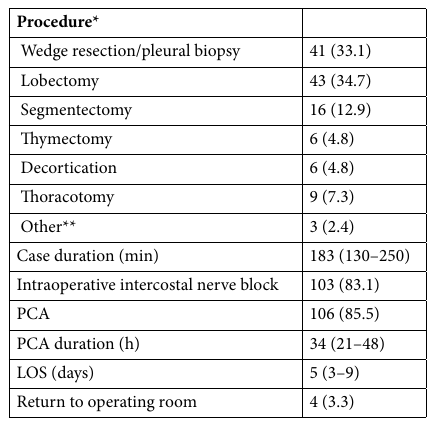
Table 3. Operative data for 124 patients undergoing thoracic surgery. PCA patient-controlled analgesia, LOS length of stay. *Data are reported as numbers (percentiles) and medians (interquartile ranges). **Diaphragm plication, resection of thoracic esophageal leiomyoma, and thoracic duct